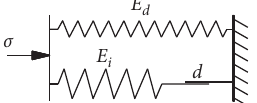
Figure 2: Double-spring model.